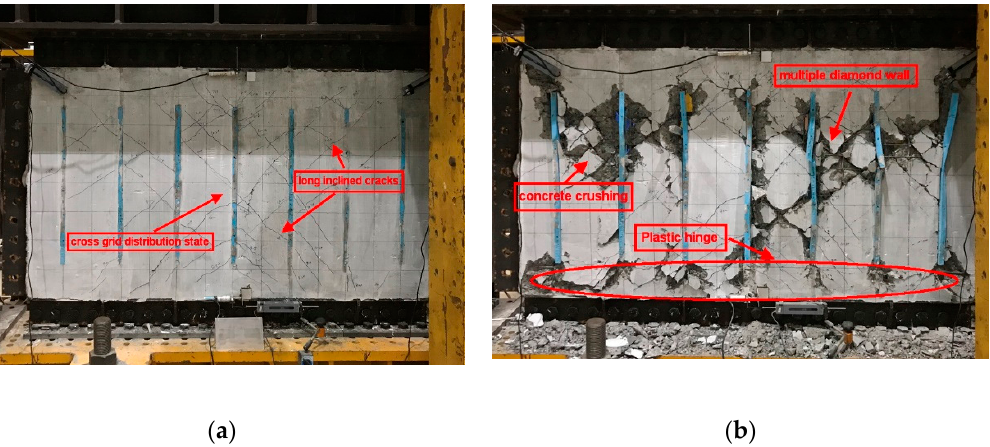
Figure 9. Images of RCIP-4 in different states: ( a ) at a drift ratio of 1.5%; ( b ) front view after the test. Failure mode I: For RCIP-1 and RCIP-4, which had penetrated slits, a few inclined cracks appeared at the ends of the slit walls during the initial loading stage. Several hori- zontal cracks appeared at both ends of the slit walls during the loading process. The con- crete at the corner was crushed in the later loading stage, and plastic hinges developed at both slit wall ends. In this RC panel type, horizontal shear was transferred through the flexural bending of the slit walls. The failure mode is shown in Figure 10a. The most im- portant reason of the occurrence of the preferable flexural failure mode is that the integral RC panel is divided into a series of slit walls with a large aspect ratio, which usually pro- duce the ductile flexural deformation mode. Failure mode II: For RCIP-2 with CVSs and RCIP-3 with CHSs, before the CVSs and CHSs were crushed during the initial loading stage, the RC panel exhibited a shear-dom- inated failure pattern and had several extended inclined cracks. Lateral shear was mainly transferred through inclined compression. During the loading process, the concrete in the CVSs and CHSs was crushed, and horizontal cracks developed at both slit wall ends, and the deformation pattern of the RC panel changed from shear to flexure. In the later loading stage, the RC panel also developed flexural plastic hinges at both ends of the slit walls and sustained lateral shear through flexural-dominated deformation of the slit walls. The fail- ure mode is depicted in Figure 10b. The most important reason for developing the two- stage mechanical feature is the adoption of CVSs and CHSs, which can be regarded as a fuse that provides the much larger lateral stiffness and peak load at the initial loading stage. Furthermore, the large aspect ratio of slit walls is achieved at the second loading